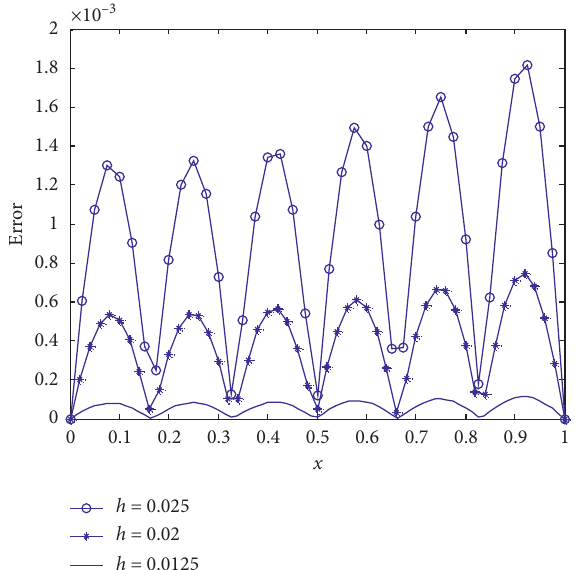
Figure 7: The point-wise absolute errors of Example 3 for different values of mesh size h, ε � 2 − 8 , and δ � 0 . 5 ε .